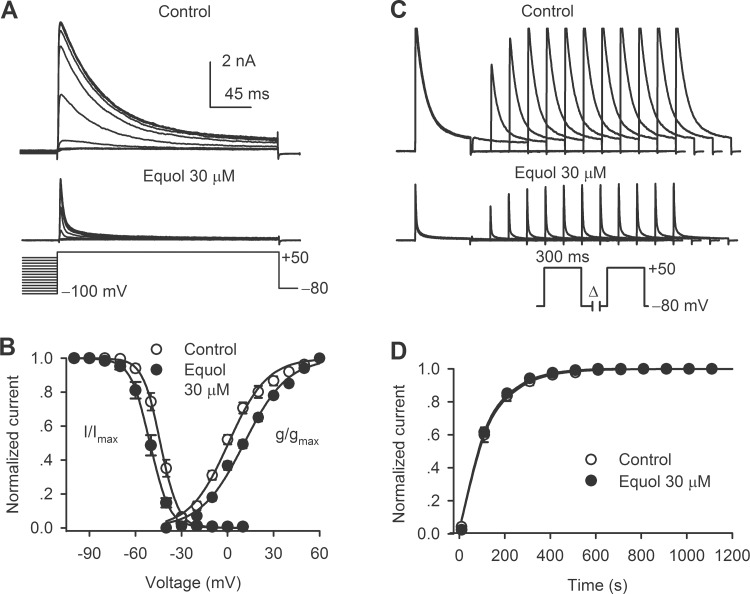
Effect of equol on hKv4.3 kinetics.(A) Voltage protocol and hKv4.3 traces for assessing voltage-dependence of hKv4.3 inactivation in the absence and presence of 30 μM equol. (B) Normalized voltage-dependent variables of hKv4.3 current inactivation (I/Imax, n = 7) and activation (g/gmax, n = 7) were fitted to the Boltzmann equation. (C) Voltage protocol and current traces for assessing recovery of hKv4.3 from inactivation in the absence and presence of 30 μM equol. (D) Recovery curves of hKv4.3 current from inactivation were fitted to a mono-exponential function.